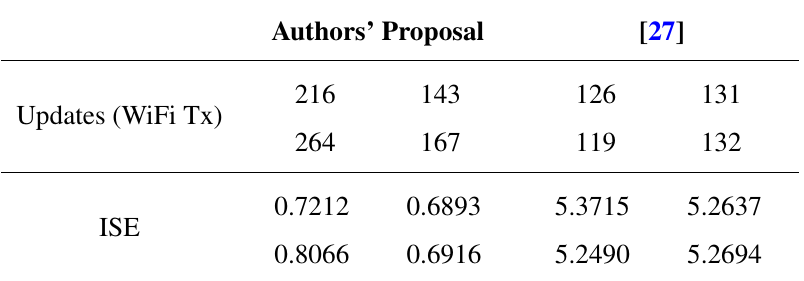
Table 4. Key parameter comparison of the experimental results obtained by the new proposal and by that described in [27]. ISE, integral of the squared error.